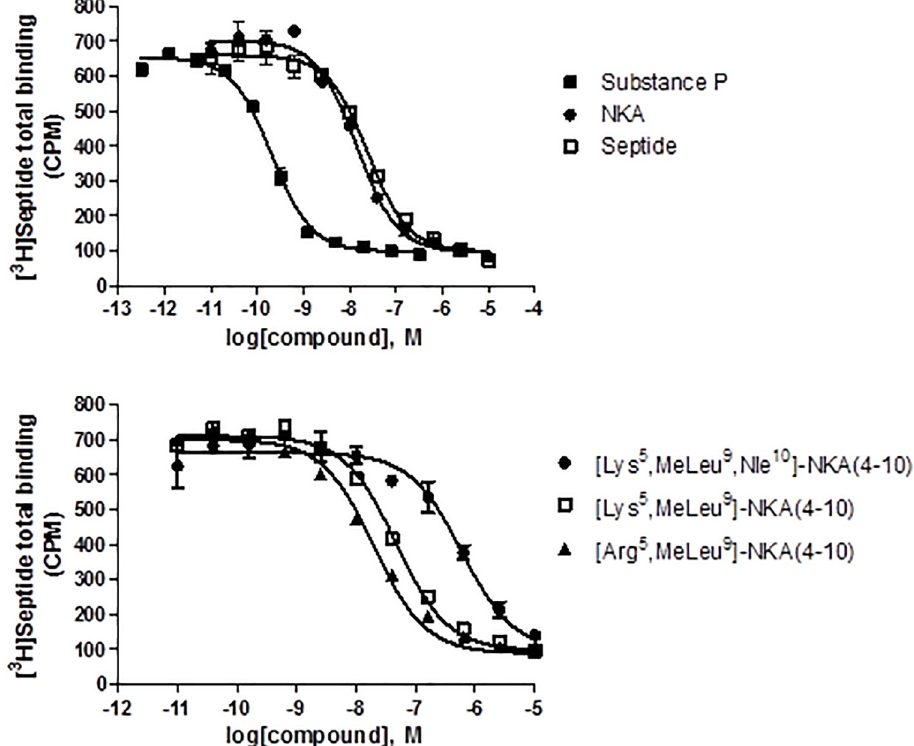
Fig 9. Representative curves showing displacement of [ 3 H]-septide binding to human recombinant NK1 receptors by substance P, NKA, septide, [Lys 5 ,MeLeu 9 ,Nle 10 ]-NKA(4–10), [Lys 5 ,MeLeu 9 ]-NKA(4–10) and [Arg 5 ,MeLeu 9 ]- NKA(4–10). Displacement curves were fitted using a one-site model. Values are means ± SD from a representative experiment performed in duplicate.